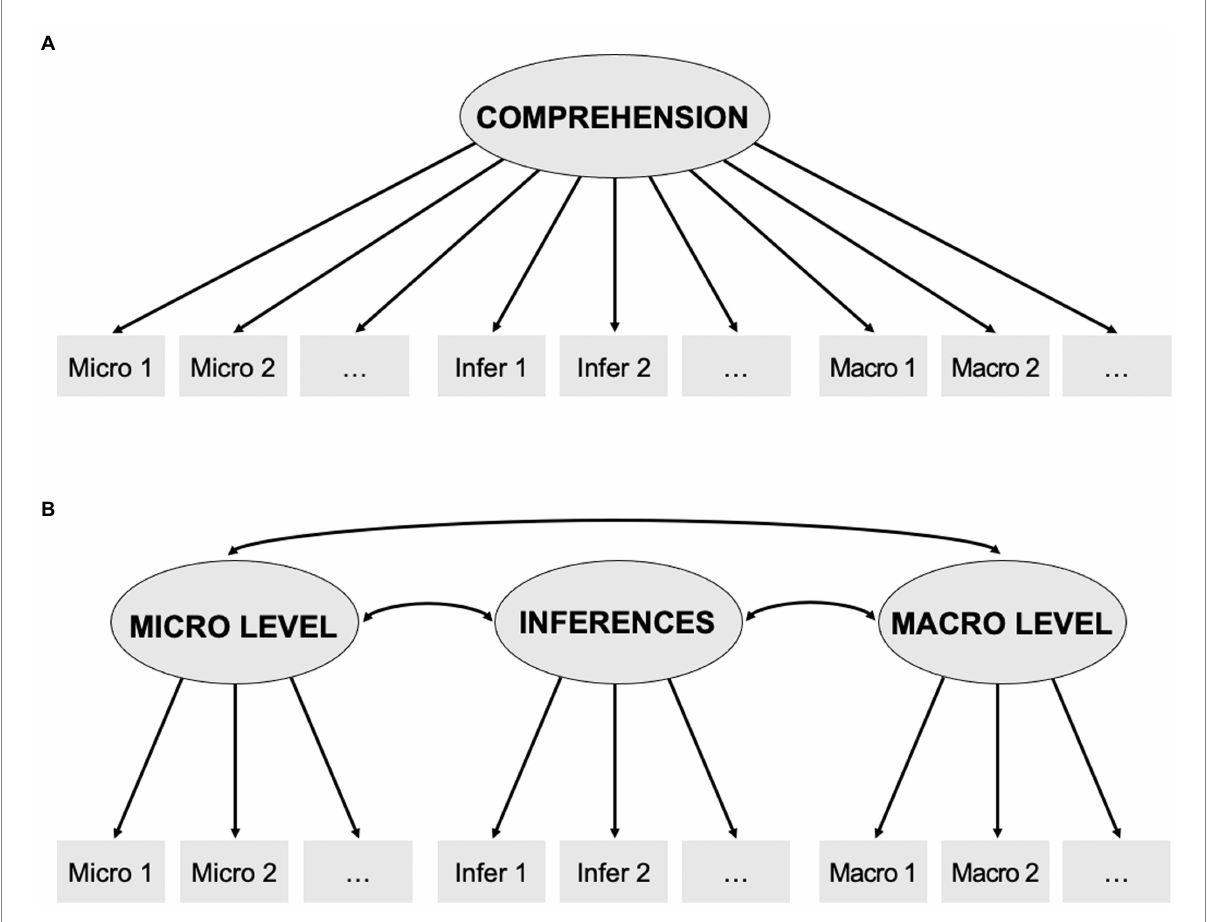
FIGURE 1 Models for confirmatory factor analysis (CFA). A: Uni-factor model of comprehension across three different items types (micro, macro, and inference level). B: Model of three correlated factors, assigning each item type its own latent